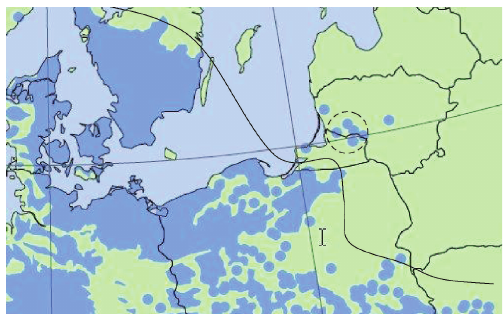
Figure 1: The edge of beech tree distribution range in north-eastern part of Europe (continuous line) and location of experimental sites (dotted line) EUFORGEN